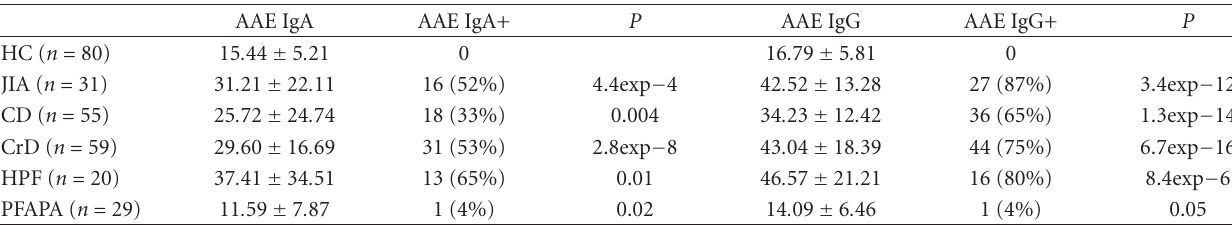
Table 2: AAE IgA and AAE IgG in healthy controls and patients. Levels and percentage of positivity of anti- α -enolase IgA and IgG in healthy controls (HCs) and patients with juvenile idiopathic arthritis (JIA), celiac disease (CD), Crohn’s disease (ChD), hereditary periodic fevers (HPF), and PFAPA syndrome (PFAPA) were reported as mean and standard deviation (SD). AAE levels are expressed as arbitrary units per mL (AU/mL) and AAE positivity as number and percentage of sera with titre above the cut-o ff . Patients’ AAE levels are compared to healthy control by t -test and P values are